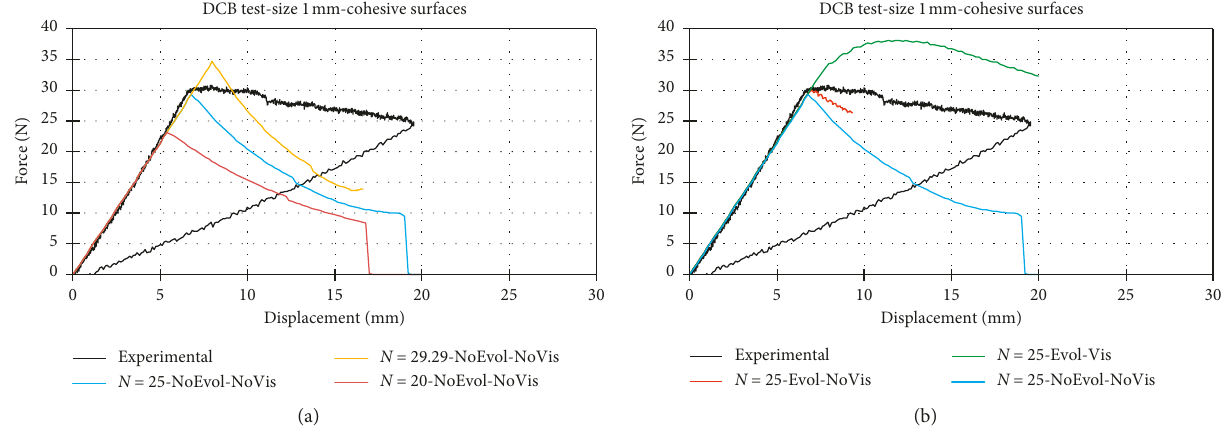
Figure 17: DCB test: cohesive surface approach (element size 1 mm).